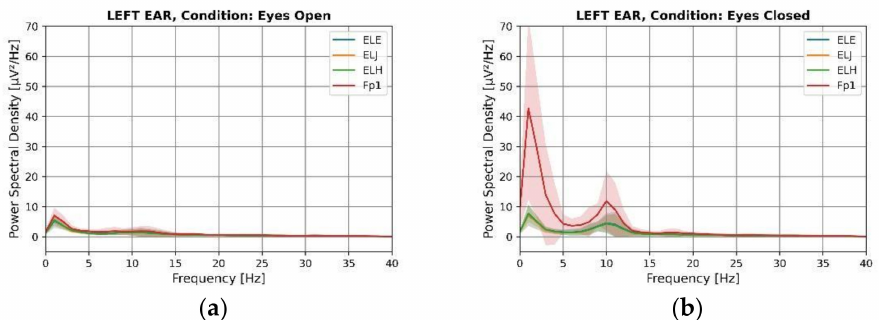
Figure 9. Power spectral density of electrodes for left ear measurements of eyes-open ( a ) and eyes- closed ( b ) conditions.